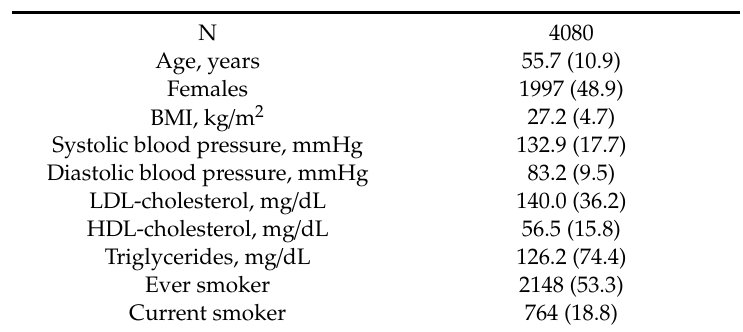
Table 1. Baseline characteristics of the population studied. Continuous variables are shown as mean values (standard deviation), and categorical variables are shown as numbers